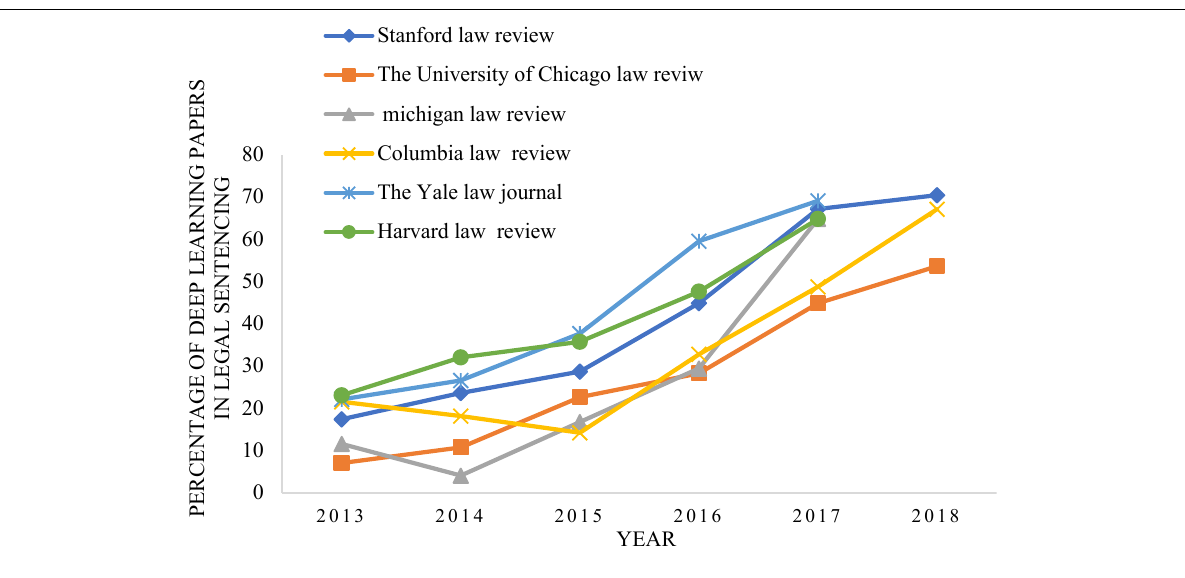
FIGURE 2 | The proportion of papers related to the application of deep learning in the legal sentence in various famous journals in recent